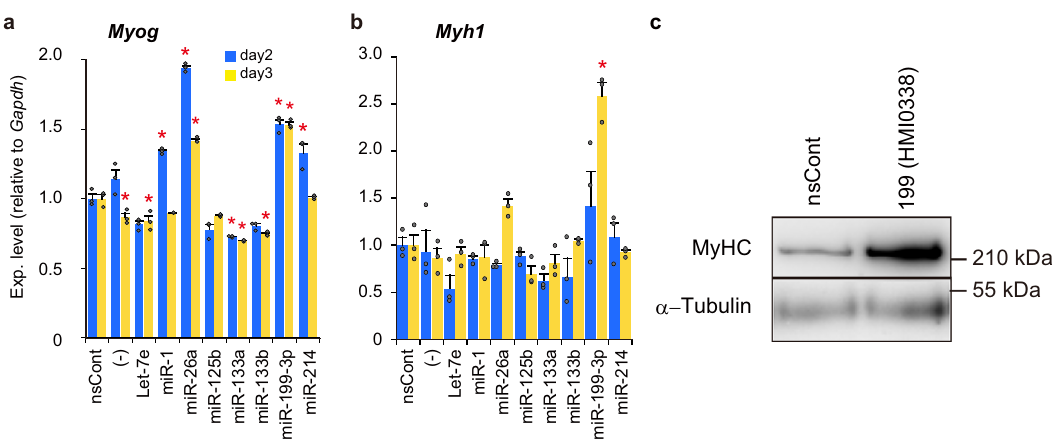
Fig. 2 Effects of miRNAs on myogenic differentiation. a , b Expression of myogenic differentiation marker genes. MiRNAs (indicated) that are more abundant in young mouse blood than in aged mouse blood were examined. Synthetic miRNAs (Mission ® microRNA mimics) were introduced into C2C12 cells; and 2 and 3 days after miRNA introduction, the expression of Myog ( a ) and Myh1 ( b ) was examined by qRT-PCR as in Fig. 1b. Cells treated with non- silencing control RNAs (nsCont) and untreated cells ( − ) were also examined as a control. Normalized data were further normalized with the data obtained from cells treated with nsCont as 1. Data are shown as mean ± SEM ( n = 3 independent determinations; * p < 0.001 by Dunnett ’ s test). c Myosin